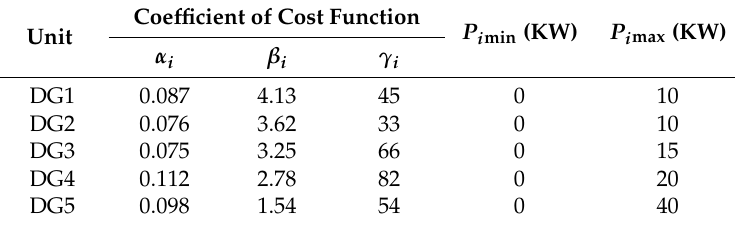
Table 2. Coefficient of cost function for the microgrid system.